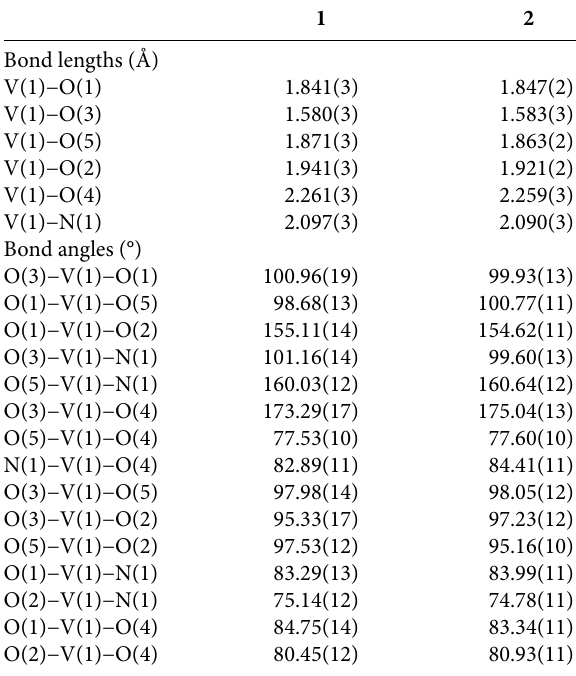
Table 2. Selected bond lengths (Å) and angles (°) for the